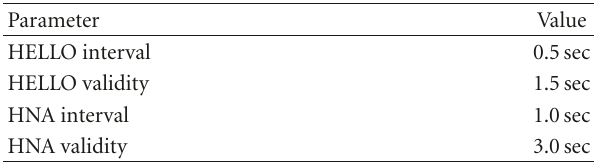
Table 2: OLSR parameters for the MANEMO experiments.